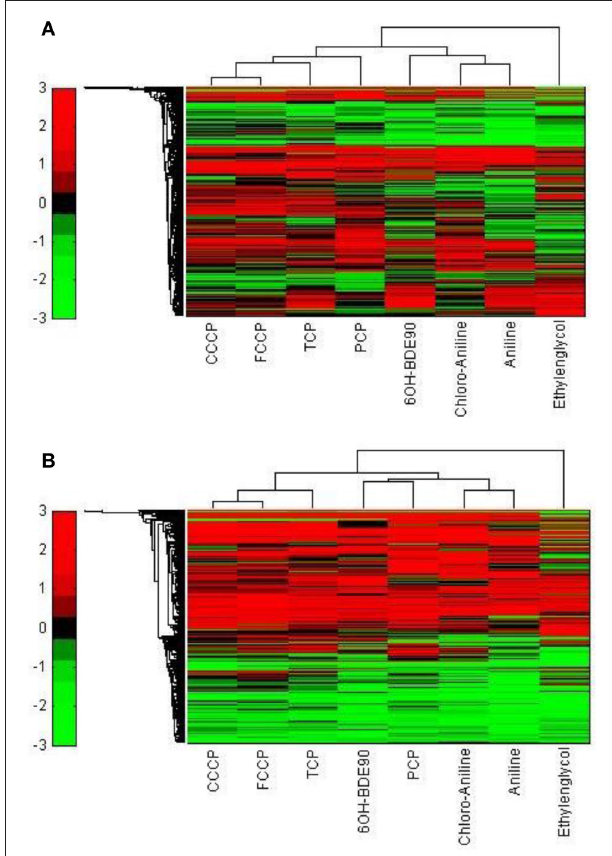
FIGURE 9 | Hierarchical cluster analysis of C3A cells exposed to eight compounds including 6OH-BDE90 (Ethylenglycol, Cl-aniline, Aniline, PCP, CCCP, FCCP, and TCP). (A) The hierarchical cluster analysis is based on the significantly regulated genes (|M| > 2 and p adj < 0.1). (B) The hierarchical cluster analysis is based on the 5000 most varying